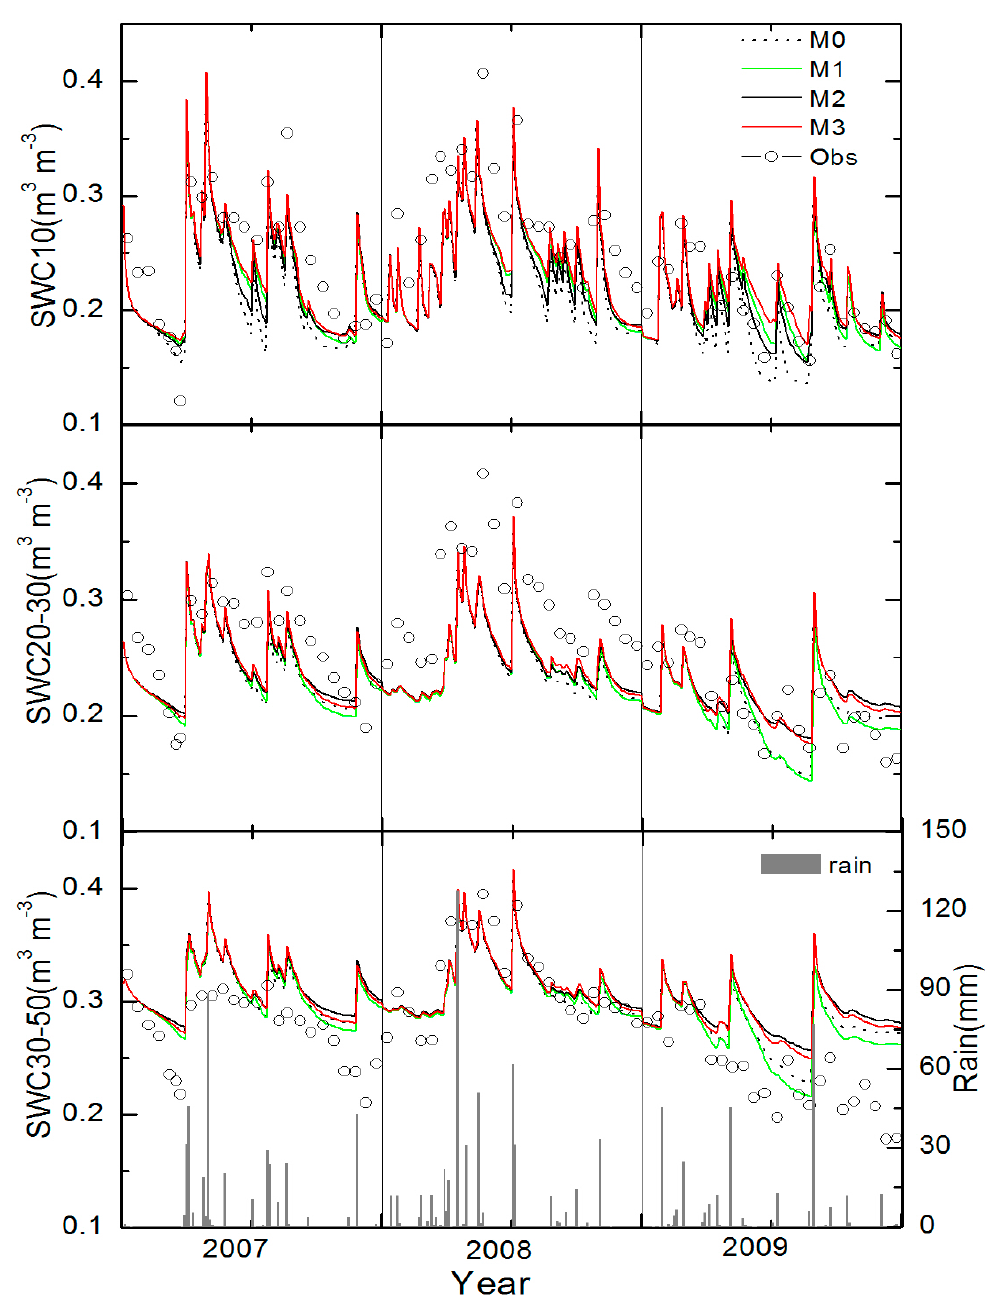
Figure 5. Comparison between the observed and the daily simulated SWC at different depths—10 cm (SWC10), 20–30 cm (SWC20–30), and 30–50 cm (SWC30–50) based on the CoLM model with four schemes, M0–M3, during the 2007–2009 growing seasons (June–September). The grey column indicates daily precipitation during the growing seasons in